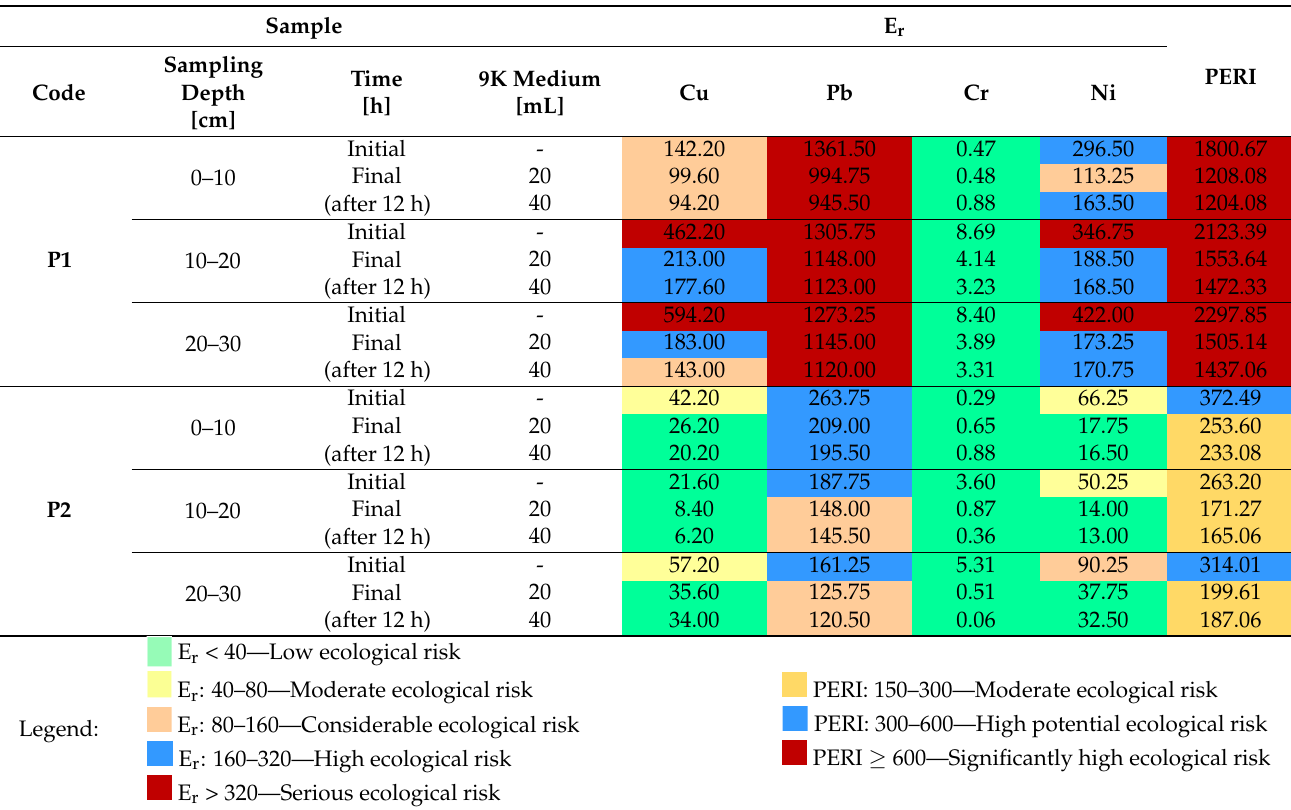
Table 3. Ecological risk index E r and PERI potential ecological risk, recorded after 12 h of treatment with 20 mL and 40 mL 9K medium solution,